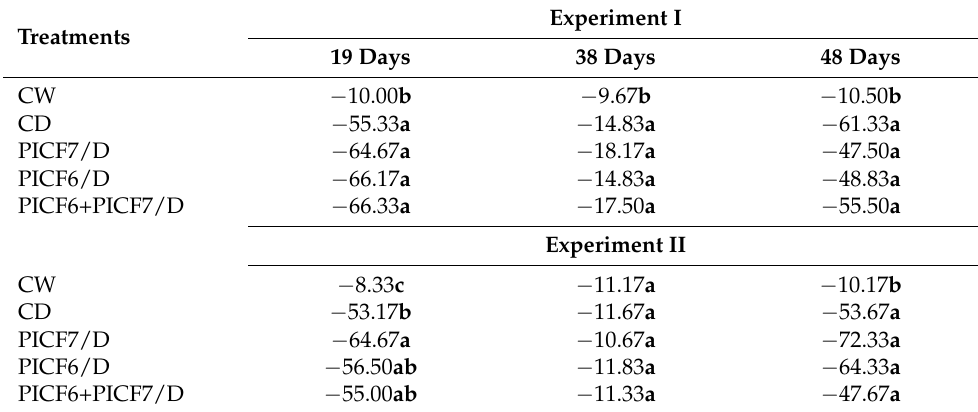
Values are expressed in MPa. Data are means of three plants. Different letters in a column represent significant differences among treatments at the same sampling time according to Tukey (HDS) test. CW, control plants solely irrigated with water; CD, plants subjected to drought stress with no water; PICF7/D, plants inoculated with Pseudomonas simiae PICF7 without subsequent watering; PICF6/D, plants inoculated with Pseudomonas sp. PICF6 without subsequent watering; PICF6+PICF7/D, plants co-inoculated with PICF6 and PICF7 without subsequent